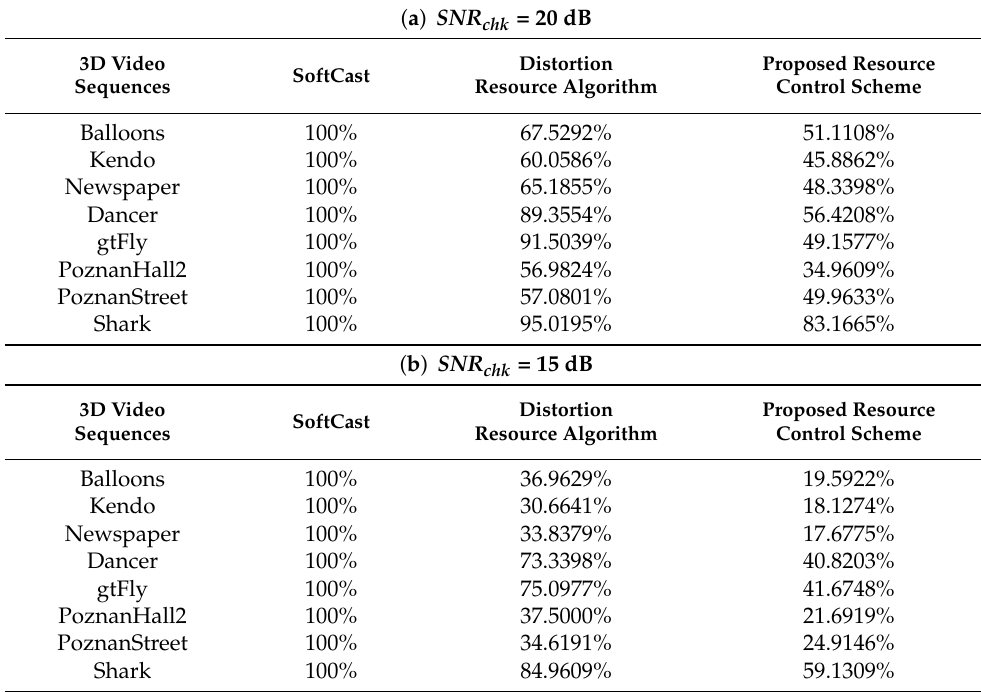
Figure 3. Bandwidth usage savings and PAR influence: ( a ) SNR chk = 15 dB; ( b ) SNR chk = 10 dB; ( c ) SNR chk = 5 dB; ( d ) SNR chk = 0 dB. Table 3. Bandwidth usage comparison for different 3D video